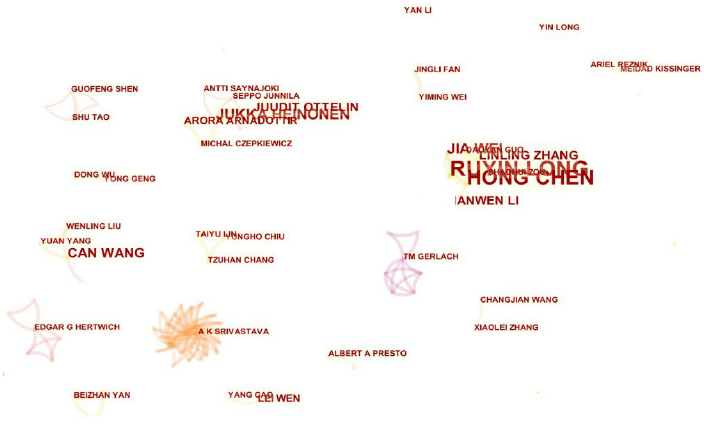
Figure 3. Map of a collaborative network of authors in the field of resident carbon emission.